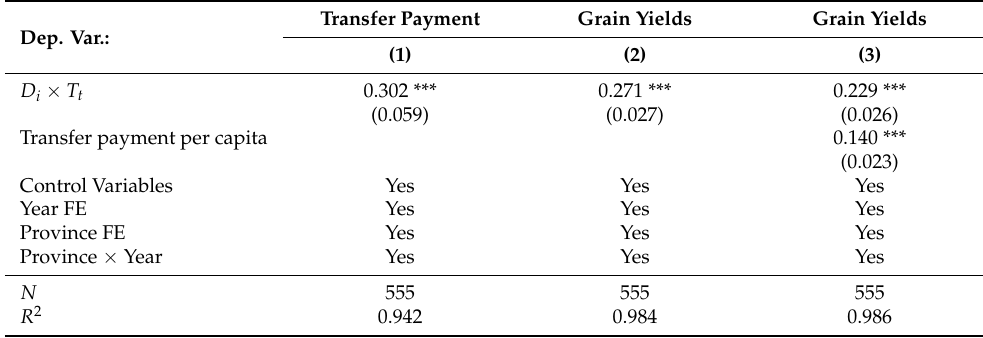
Table 13. Channel 3—increasing transfer